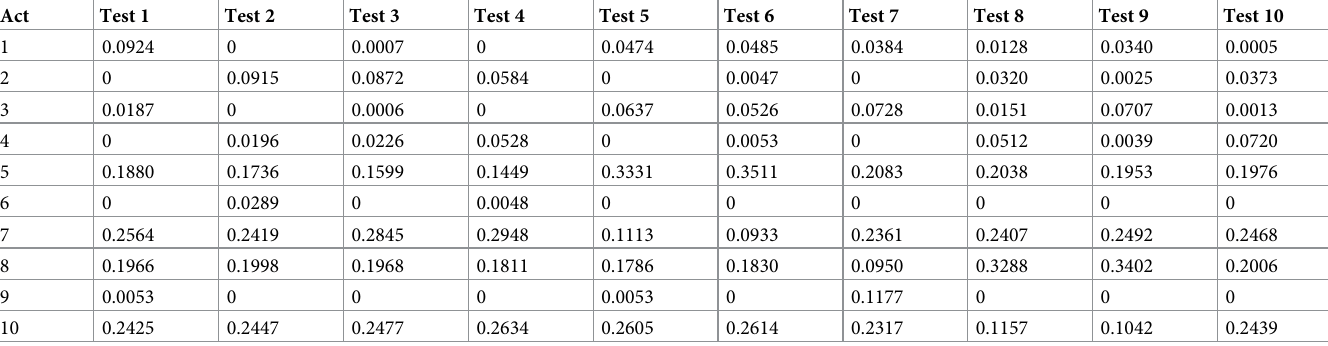
Table Legends: Act—activities. Test #—simulation test. Each column—ending frequencies for corresponding activities.